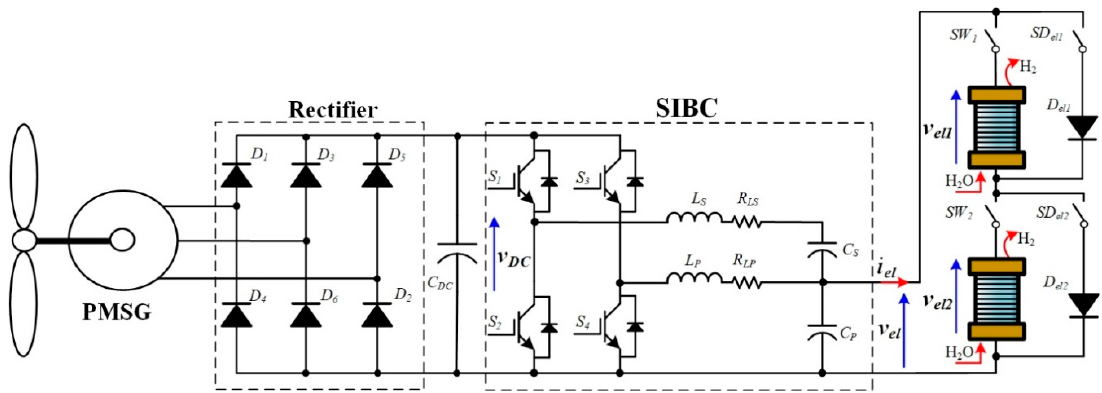
Figure 18. Multi-stack electrolyzer based on series configuration.